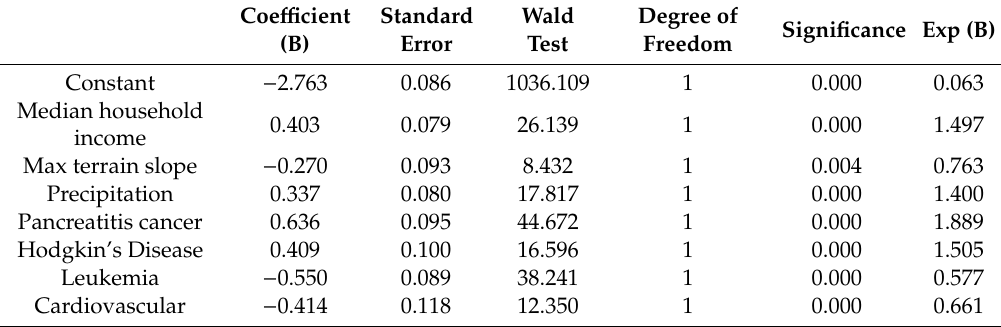
0.05) of COVID-19 incidence rate, continental United